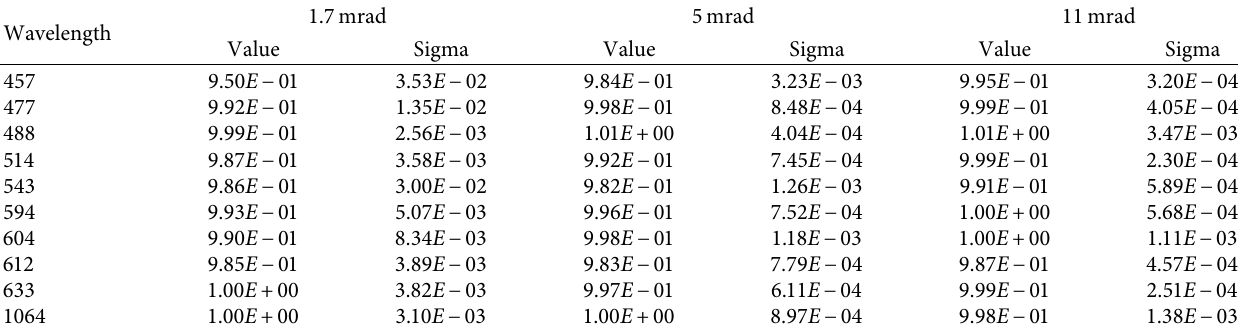
Table 2: Wavelength shift correction factor for all mrad field of view (FOV)